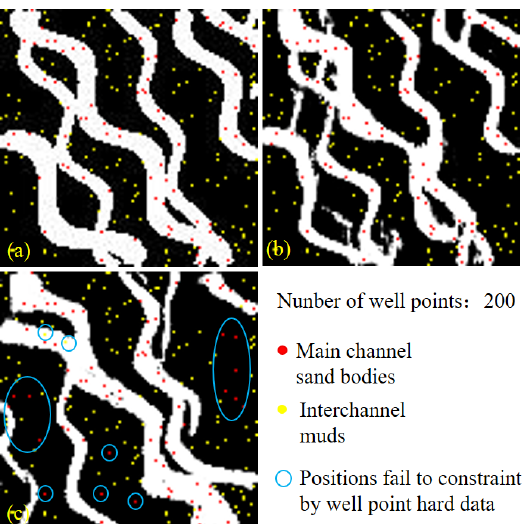
Figure 13. The comparison of the conditional modeling results between UCSC method and the tra- ditional method. ( a ) Validation model; ( b ) model established by UCSC method; ( c ) model estab- lished by Snesim; ( d ) model established by Filtersim.